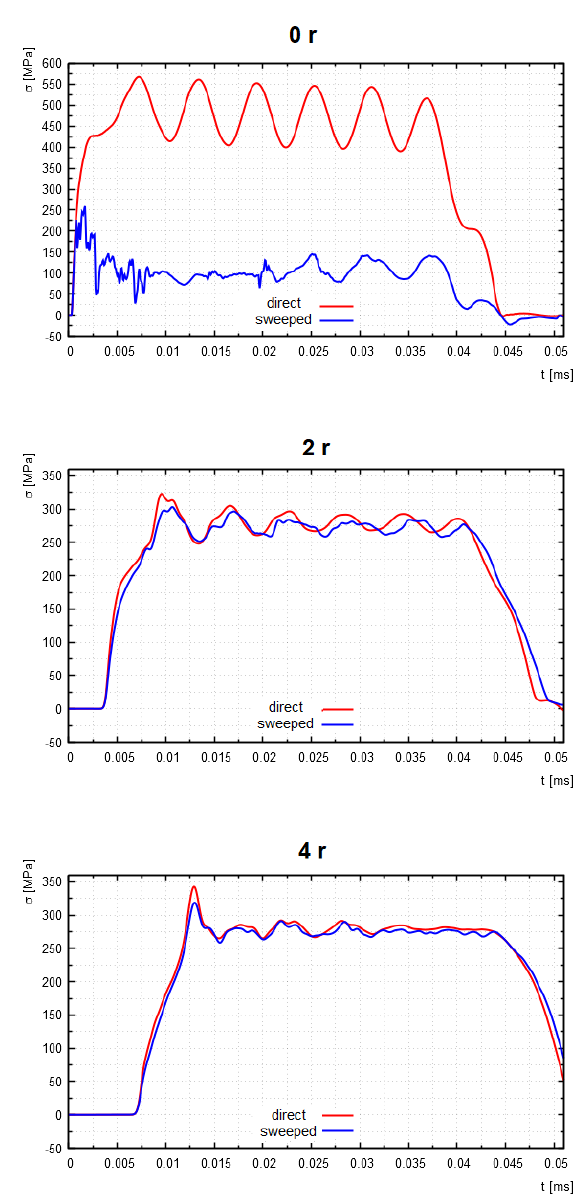
Figure 6. An evolution of the stress wave - measured at the front of the bar (top), one diameter distance (middle) and two multiples of the diameter distance